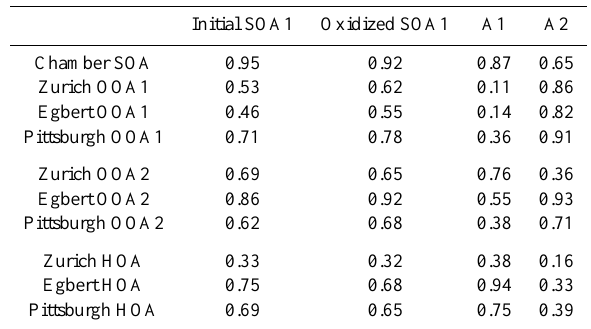
Table 2. R 2 values of PMF factors A1 and A2 in this work com- pared to laboratory chamber SOA (Bahreini et al., 2005) and PMF factors from ambient data for the following studies: Zurich (Lanz et al., 2007), Egbert (Slowik et al., 2009), Pittsburgh (Ulbrich et al., 2009). Oxidized SOA1 mass spectrum was taken under an OH exposure of 7.6 × 10 − 8 atm-s.